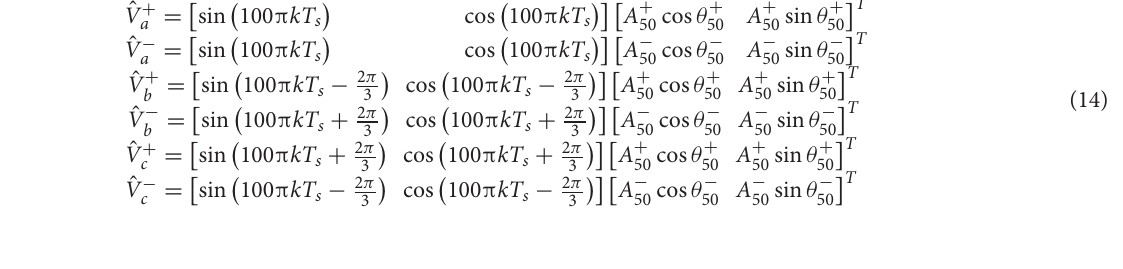
TABLE 2 | Parameters of adaptive SMC. Adaptive SMC parameters for current loop for positive and negative loops α d = α q = 0.9